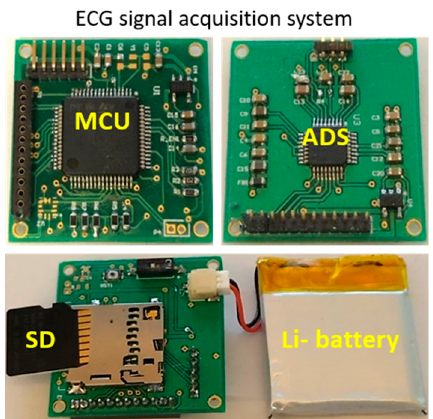
Figure 3. A custom-designed printed circuit board (PCB) including a 32-bit micro-controller unit (MCU), a fully integrated ECG analog front-end (ADS), a local secure digital media (SD) card, and a portable